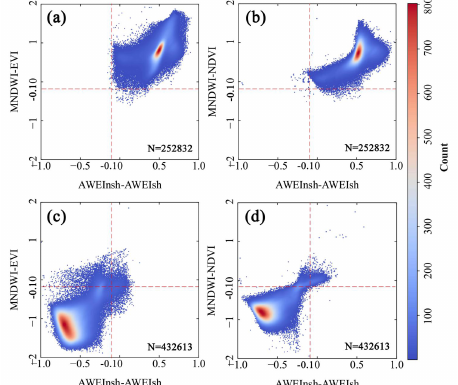
Figure 4 . Density scatter of water (a-b) and non-water (c-d)